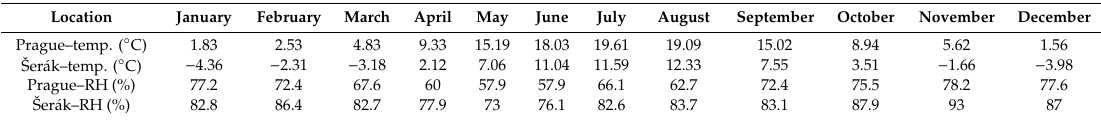
Table 3. Averaged climatic data for Prague and Šerák region.